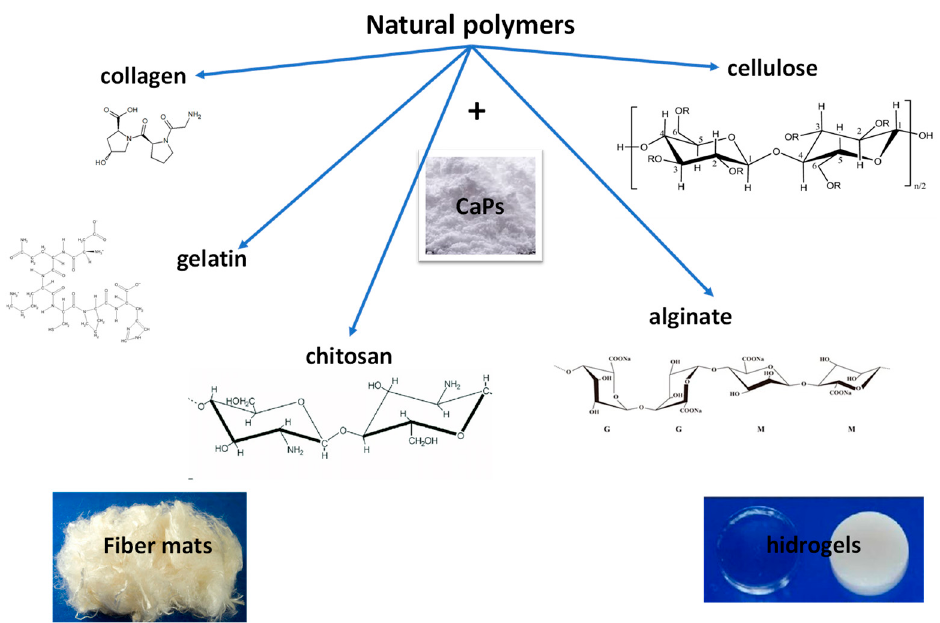
Figure 2. Graphical illustration of the most common natural polymers that can be used as CaP- containing composites. The applications of these materials are extremely broad, since they can be produced either as hydrogels or fiber mats.